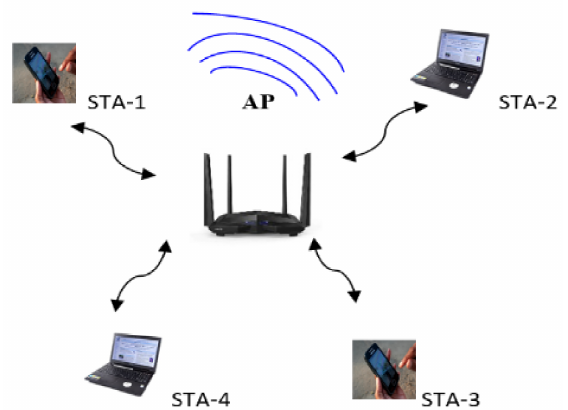
Figure 1. Network topology